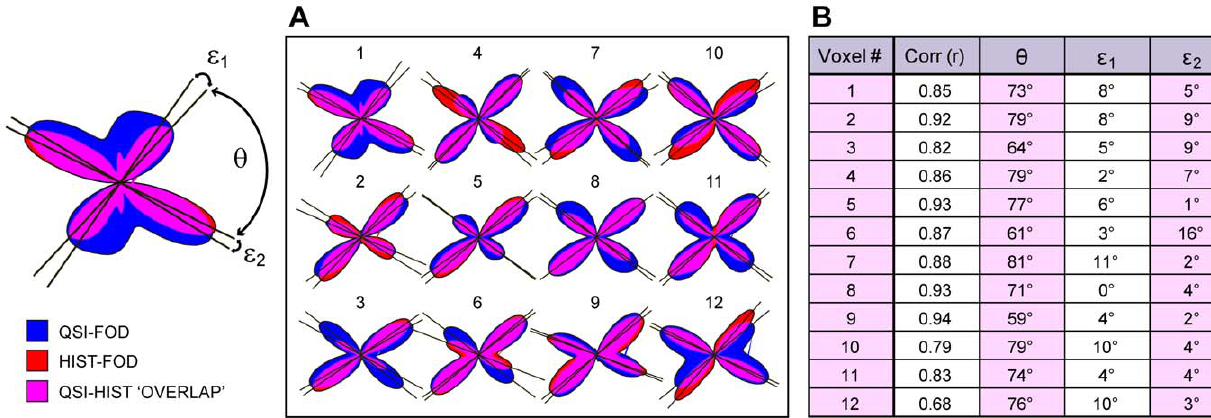
Figure 5. Quantitative comparison of fiber orientation distributions in ROI-2. ( A ) Superimposed HIST-FODs (red) and QSI-FODs (blue) are shown for each of the 12 voxels in ROI-2, together with peak orientations (black lines) for the respective fiber orientation distributions. Purple color indicates FOD overlap. ( B ) For quantitative analysis, the acute intersection angle of the HIST-FODs ( h ), and the angular error of both FOD peaks ( e 1 and e 2 ) are given for each of the 12 voxels together with the Pearson correlation coefficients (r) between the HIST- and QSI-FODs. The average Pearson correlation was r=0.86; SD=0.07, average intersection angle was h =73 u ; SD=8 u , average angular error ( e 1 and e 2 combined) was 5.7 u ; SD=3.8 u .